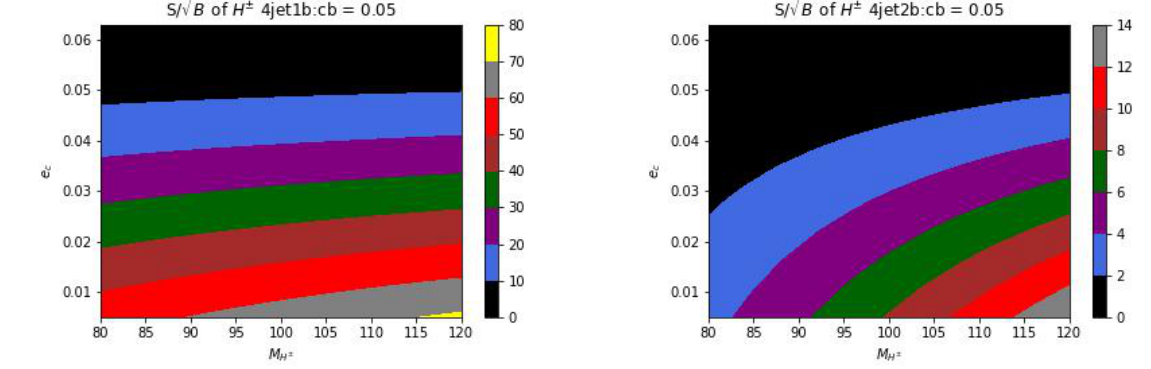
Figure 17. Significances as a function of charged scalar mass and charm tagging efficiency at an 240 GeV CEPC, at an integrated luminosity of 1ab − 1 , within a 3HDM as presented in [60], considering a c ¯ cb ¯ b final state. Figures taken from that